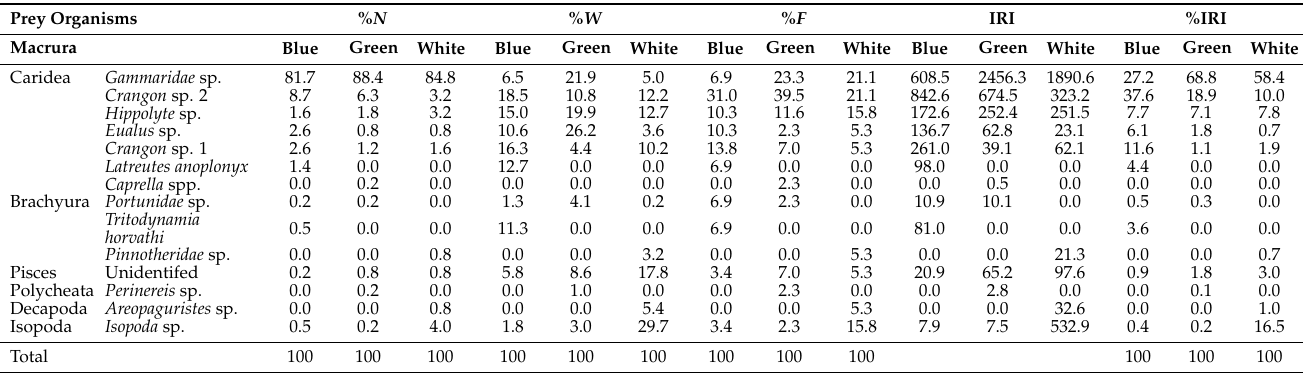
Table 4. Composition of the stomach contents of bluefin sea robins by frequency of occurrence, number of individuals, and index of relative